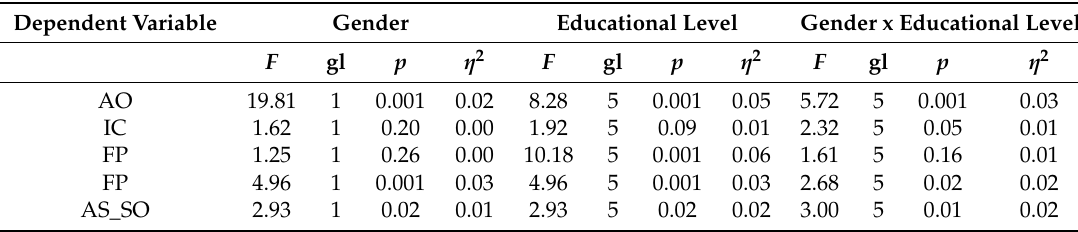
Table 5. Main effects and interaction effects of gender and educational level variables on the dimensions of academic stress. Dependent Variable Gender Educational Level Gender x Educational